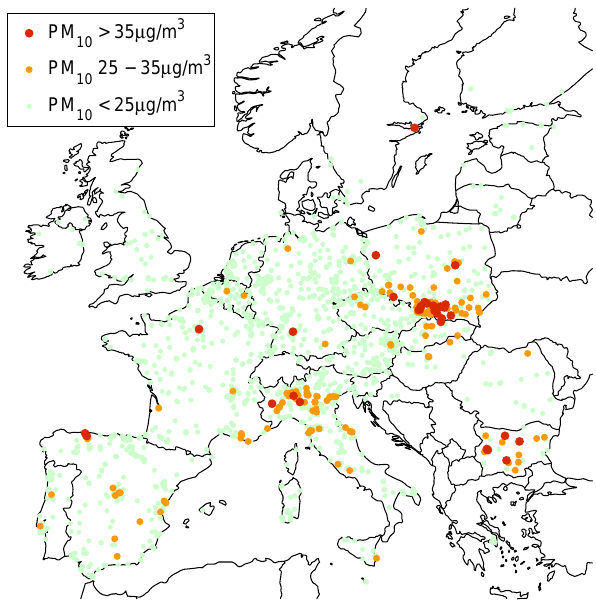
Figure 11. Modelled annual mean PM 10 concentrations at AirBase stations for the year 2030 under the CLE